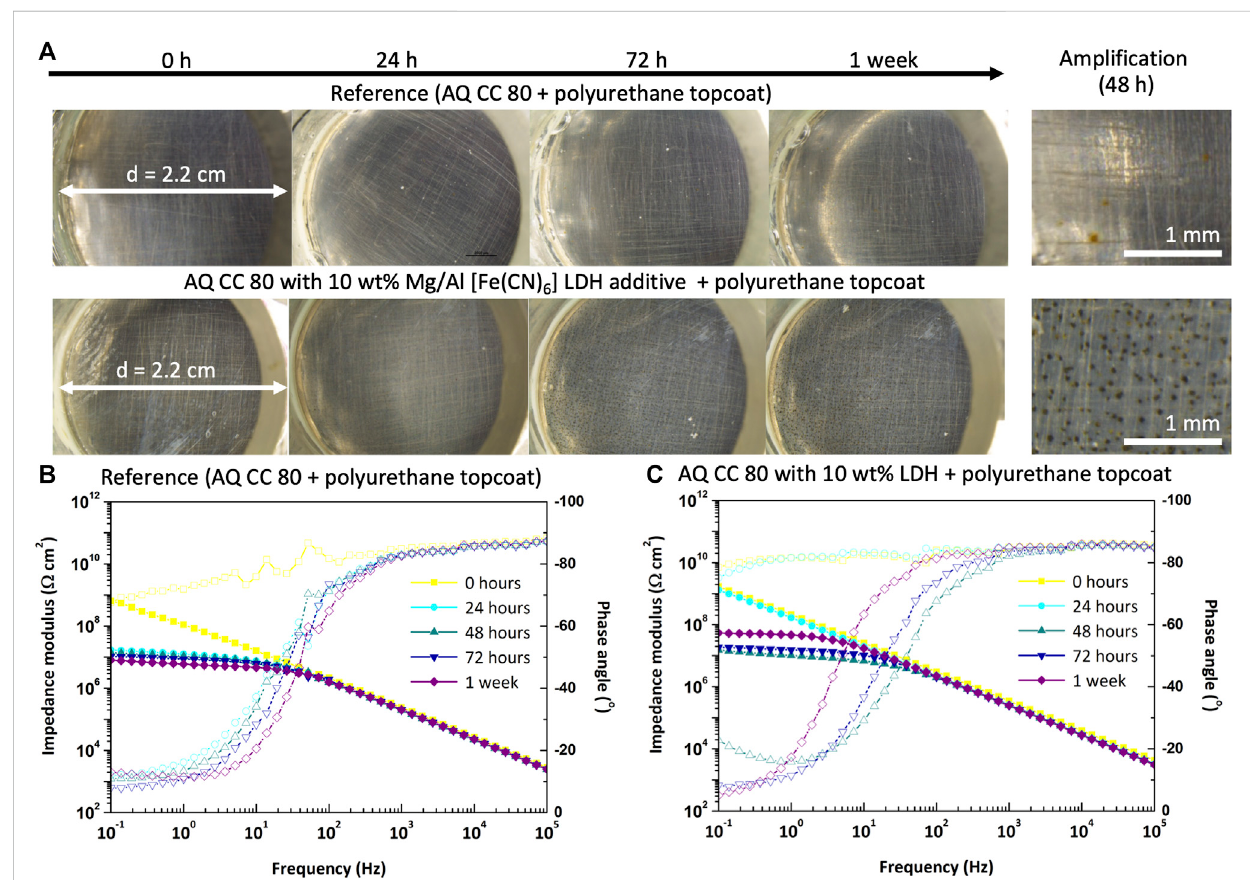
FIGURE 10 Visual analysis of the surface (A) and EIS spectra (B, C) of carbon steel plates coated with the multilayer system 2 with Mg-Al/[Fe(CN) 6 ] LDH nanoadditive (C) , and corresponding reference multilayer system (B) immersed in 0.6 M NaCl solution during 1